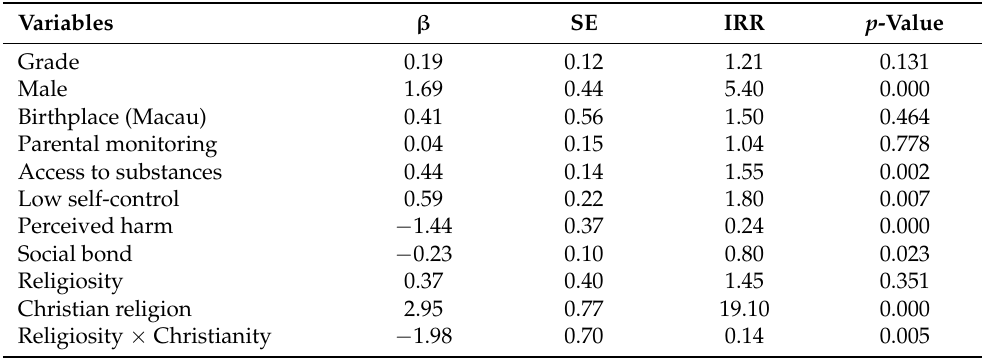
Table 2. Negative binomial regression of relationship between religiosity and frequency of adolescent substance